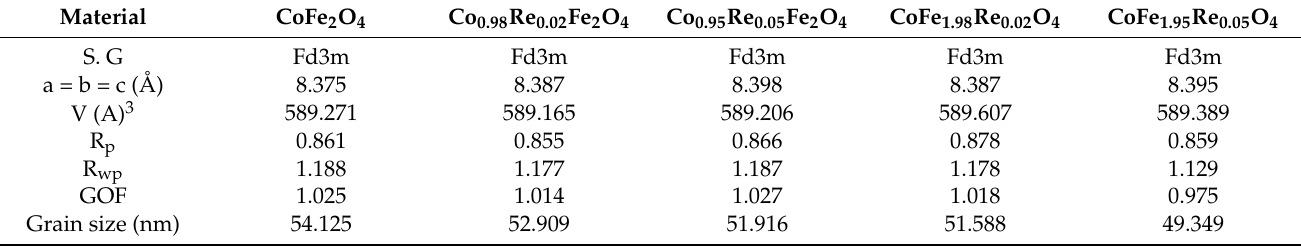
Table 1. Refined structural parameters of Re-doped nanoparticles. The grain size decreases with the doping of